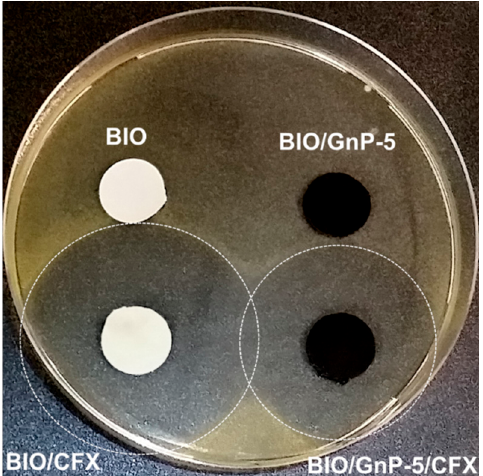
Figure 5. Agar diffusion test performed on M. luteus overlay for the materials incorporating CFX and for the respective systems without antimicrobial additive.